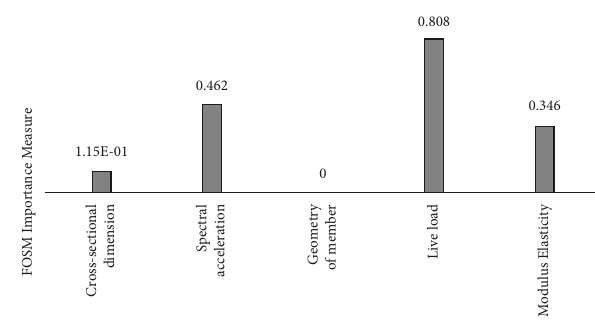
Figure 16: Scale diagram of the significance of type V frame uncertainties in the FOSM method.